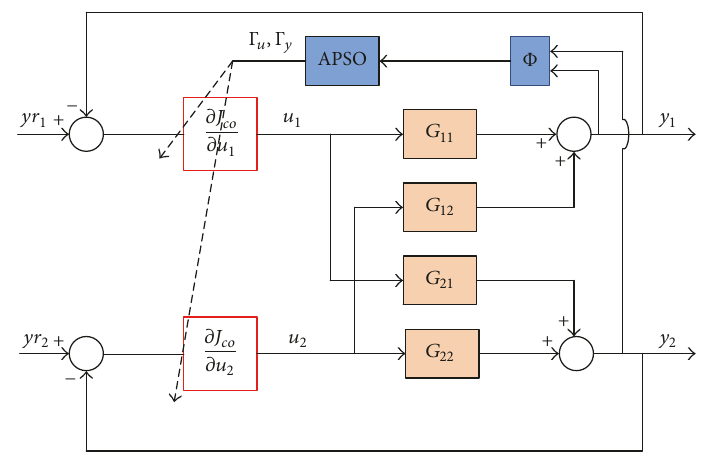
Figure 2: The control